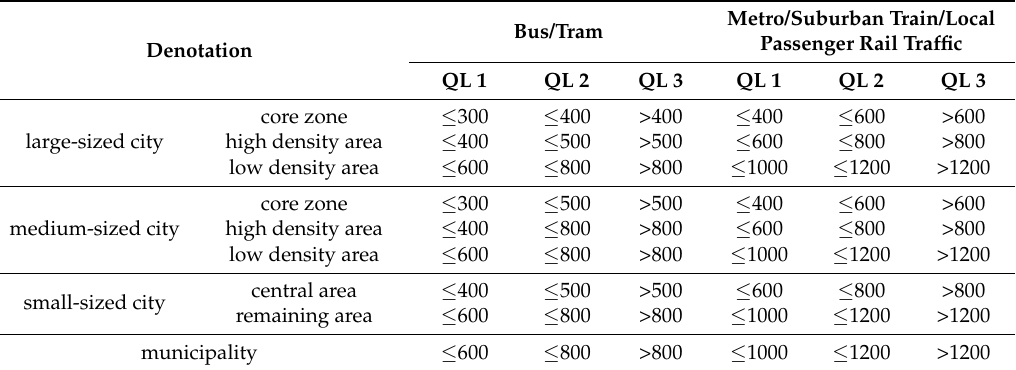
Table 2. Quality levels of accessibility (beeline) of public transport stops (unit meters) (own depiction based on